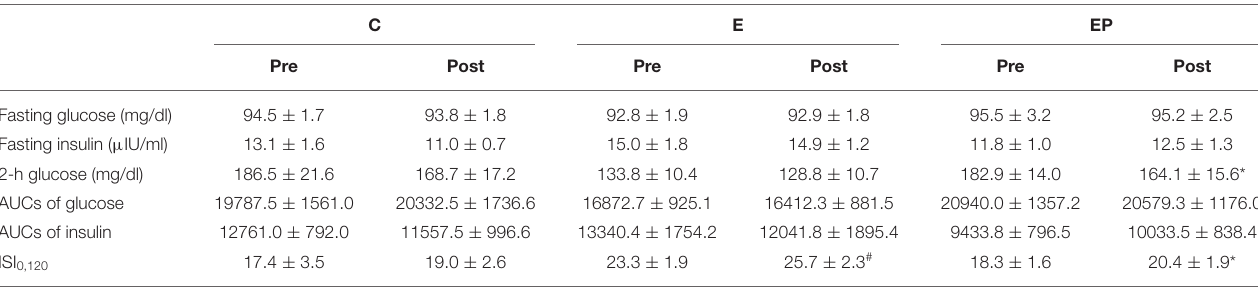
TABLE 2 | Effects of interventions on variables derived from oral glucose tolerance